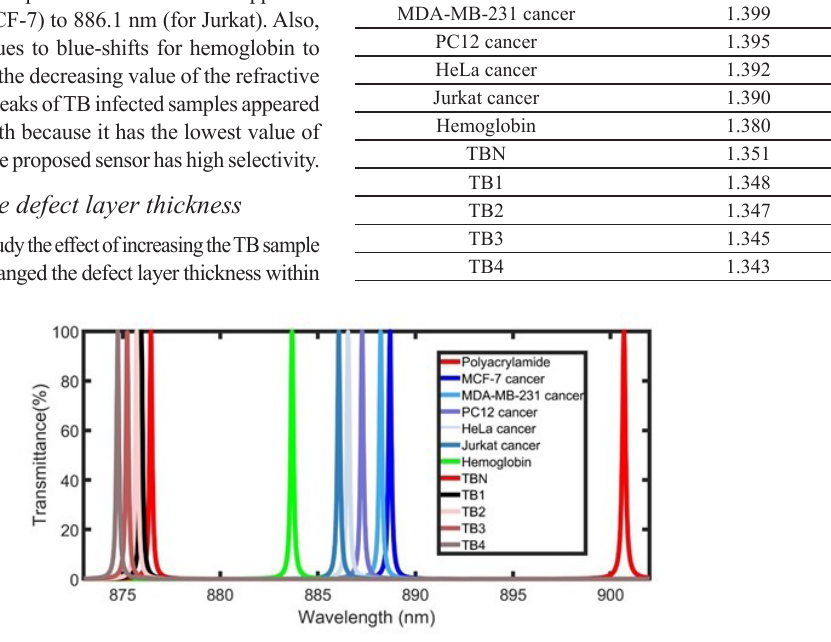
Figure 3. Transmittance spectra of defected PC with different blood components at N=7, 0 0 θ= and d